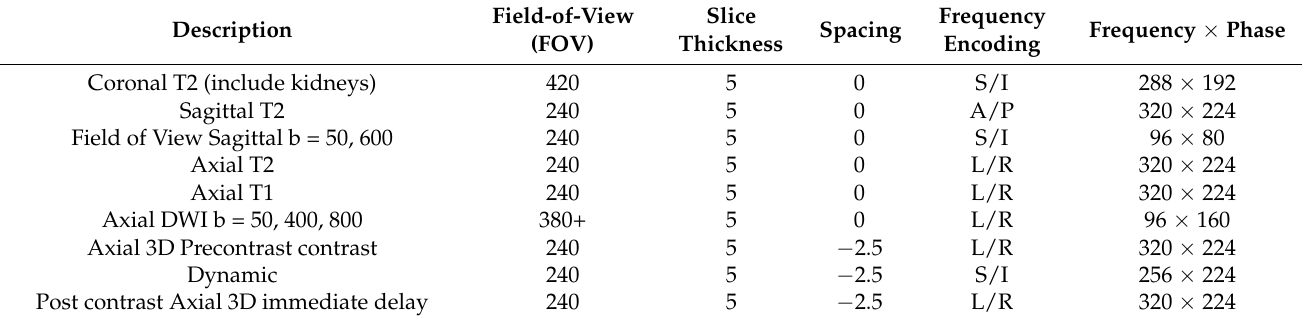
Table 4. MRI of the pelvis